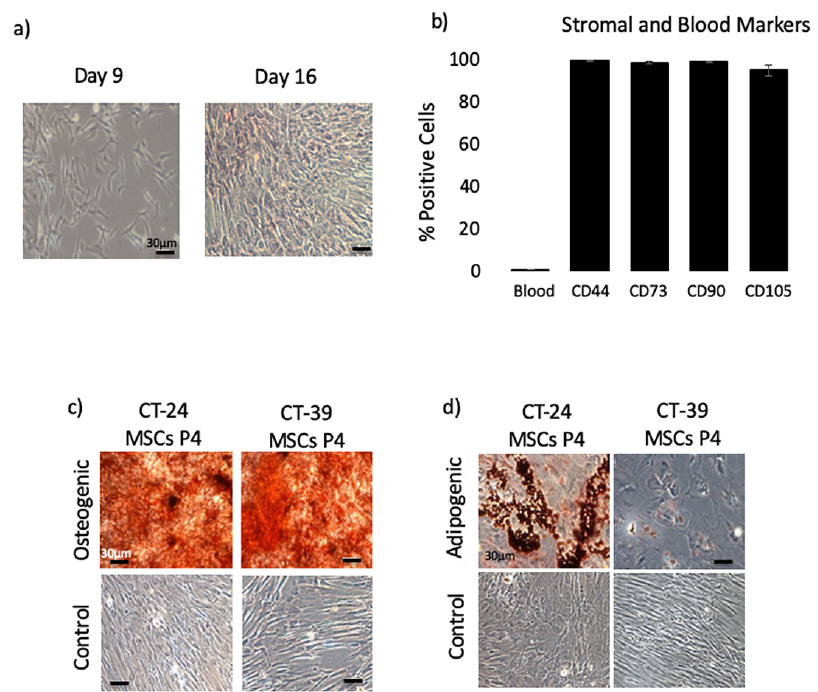
Figure 1. Characteristics of umbilical cord tissue mesenchymal stromal cells (CT-MSCs) isolated through the explant method from cryopreserved primary human umbilical cord tissue. ( a ) Cell outgrowth at Day 9 and Day 16 post-plating. The cells have a normal spindle-shaped morphology and became confluent after 16 days. (CT-MSC 200). Scale bar =30 µM for all pictures. ( b ) The cell lines are over 95% positive for the MSC markers (CD44, CD73, CD90 and CD105) and < 1% posi- tive for the hematopoietic markers (‘blood’- pooled; CD34, CD11b, CD19, CD45 and HLA-DR) at passage 4 (n = 5 cords). Standard Error bars (red) are shown. No statistical difference between pas- sages was observed. ( c ) Passage 2-4 CT-MSCs were cultured in osteogenic differentiation medium for 14 days and stained with 2% Alizarin Red solution for calcium deposits. The control well was grown in α MEM+5% FBS and showed no positive staining. Scale bar = 30 µM for all panels. ( d ) Passage 2-4 CT-MSCs were cultured in adipogenic differentiation medium for 14 days and stained with Oil Red O to stain lipid droplets. The control well was grown in α MEM+5% FBS and showed no positive staining. Scale bar = 30 µM for all panels.